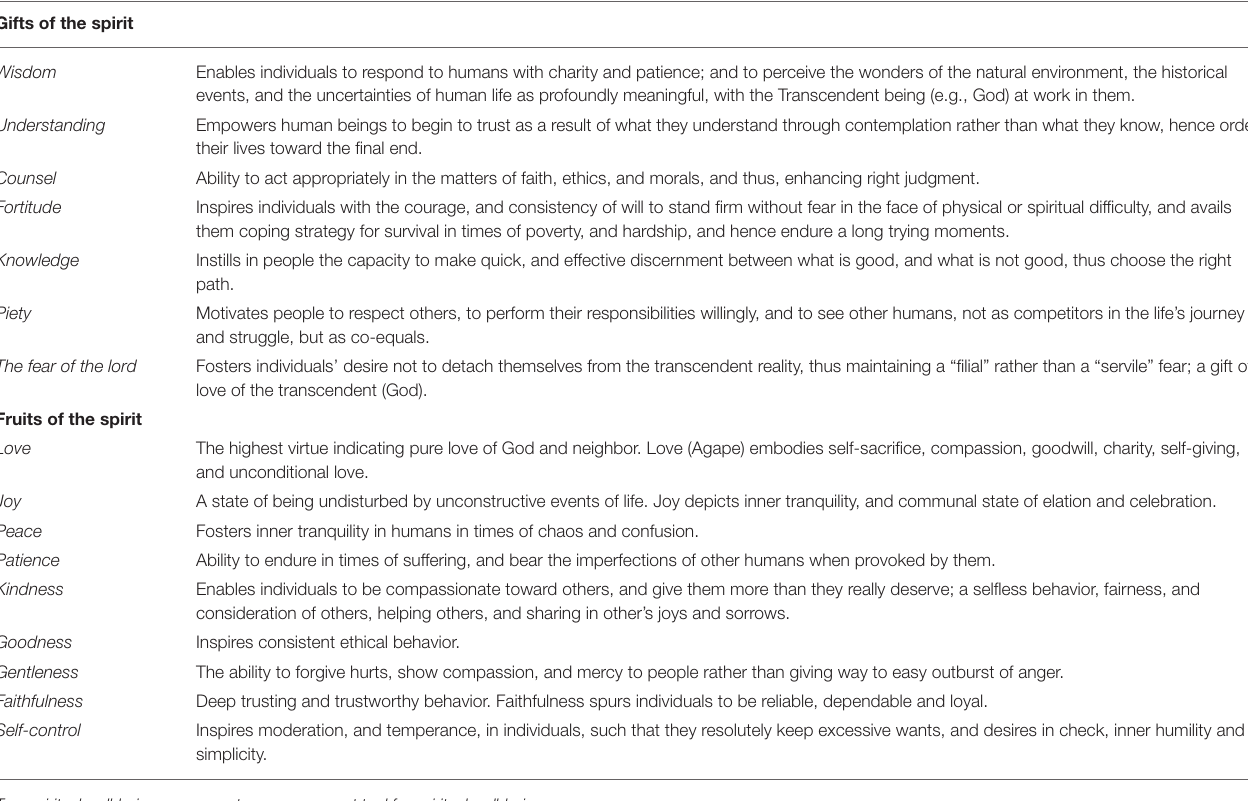
TABLE 1 | Spiritual well-being: GFSp. Gifts of the spirit